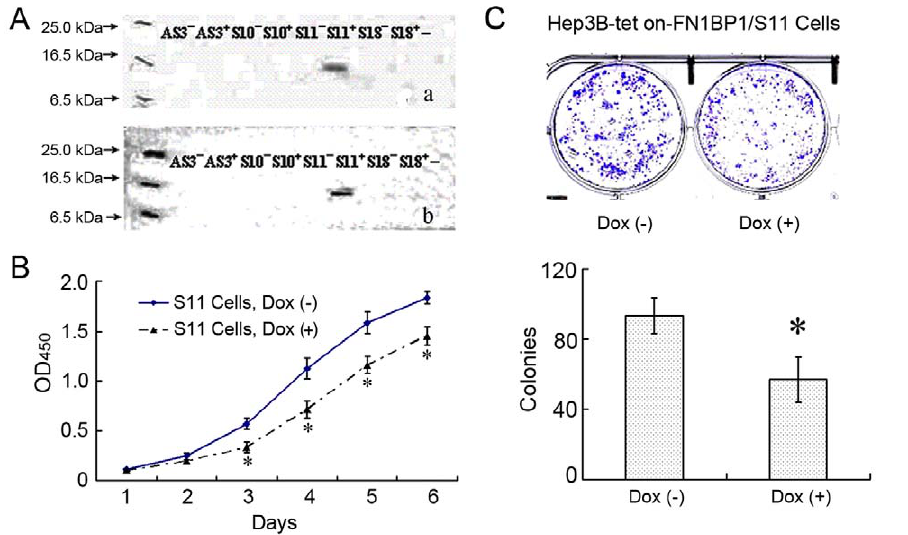
Figure 3. Inducing FN1BP1 expression in Hep3B cells reduced cell proliferation and colony formation. After screening in the medium containing hygromycin for more than 8 wk, a total of 33 independent Hyg-resistant cell lines were obtained from the Hep3B-Tet-on cells transfected with pTRE2hyg-FN1BP1. (A) The 11th sense clone of Hep3B Tet-On-FN1BP1 (marked as Hep3B-Tet-On-FN1BP1/S11) showed a positive band identified by either anti-HA tag antibody (a) or anti-FN1BP1 antibody (b) when the cells were induced by Dox. S10 and S18 represent the 10th and 18th sense clones of Hep3B Tet-On-FN1BP1. AS3 represents the third antisense clone of Hep3B Tet-On-FN1BP1, respectively. (B) The cell proliferation activity curve of 6 days shows that expression of FN1BP1 suppressed the Hep3B cell proliferation activity significantly from day 3 to day 6. The data are represented as mean 6 SD, * P , 0.05 vs non-induced S11 cells, n=4. (C) The data indicate that the expression of FN1BP1 induced by Dox distinctly decreased the cell colony formation compared to non-induced Hep3B cells, *P , 0.05, n=4. The upper panel shows the representative figure, while the statistical result is shown in the lower panel.